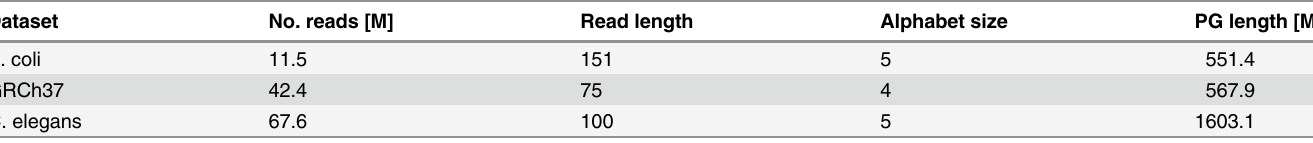
Table 2. Dataset characteristics.